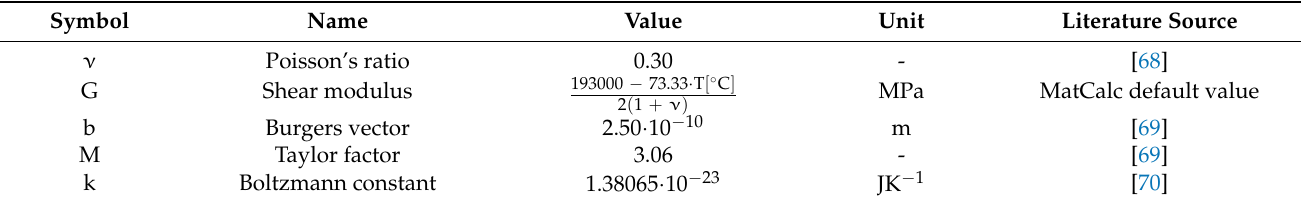
Table 2. Parameter symbols and values used for the ABC-model.